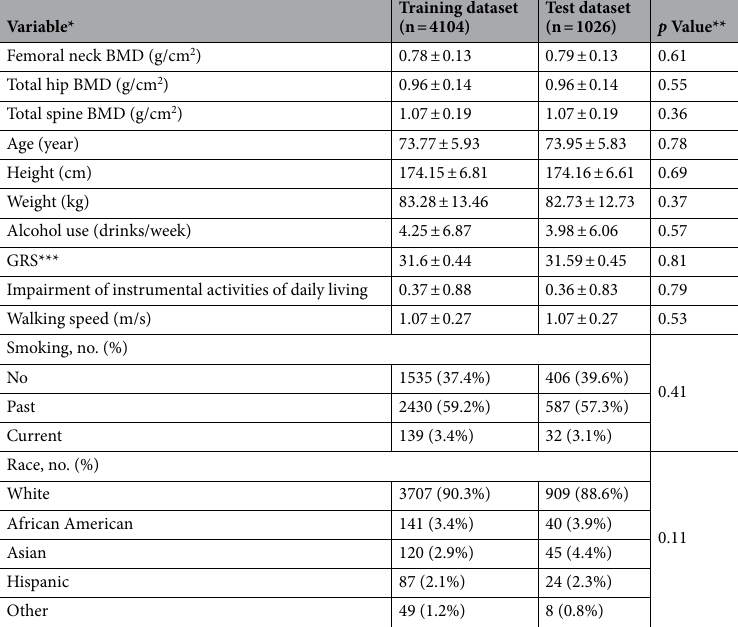
Table 1. Baseline characteristics of training and testing dataset. *Continuous variables were expressed as mean ± SD, and categorical variables were expressed as number (%). ** p Value were obtained by t-test for continuous variables and chi-square tests for the categorical variable. ***GRS: genetic risk score, which was calculated based on 1103 BMD-related